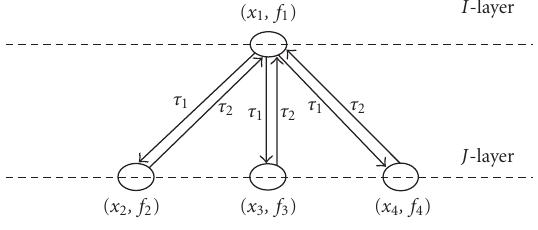
Figure 1.1. Graph of the architecture of the model